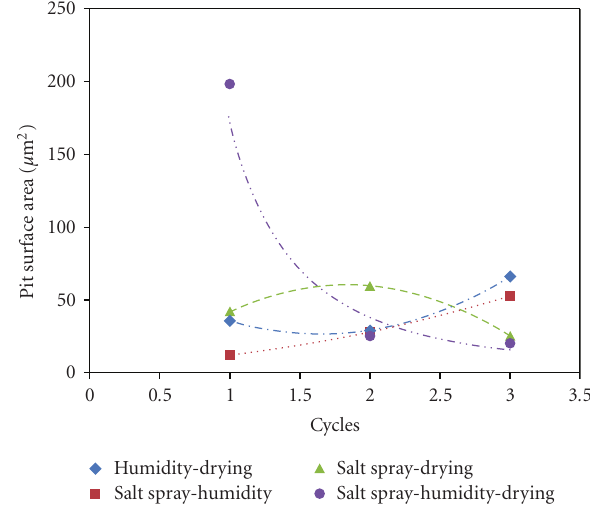
Figure 5: Average nearest neighbor distance of the AE44 coupons arranged by test condition based on cycle number.